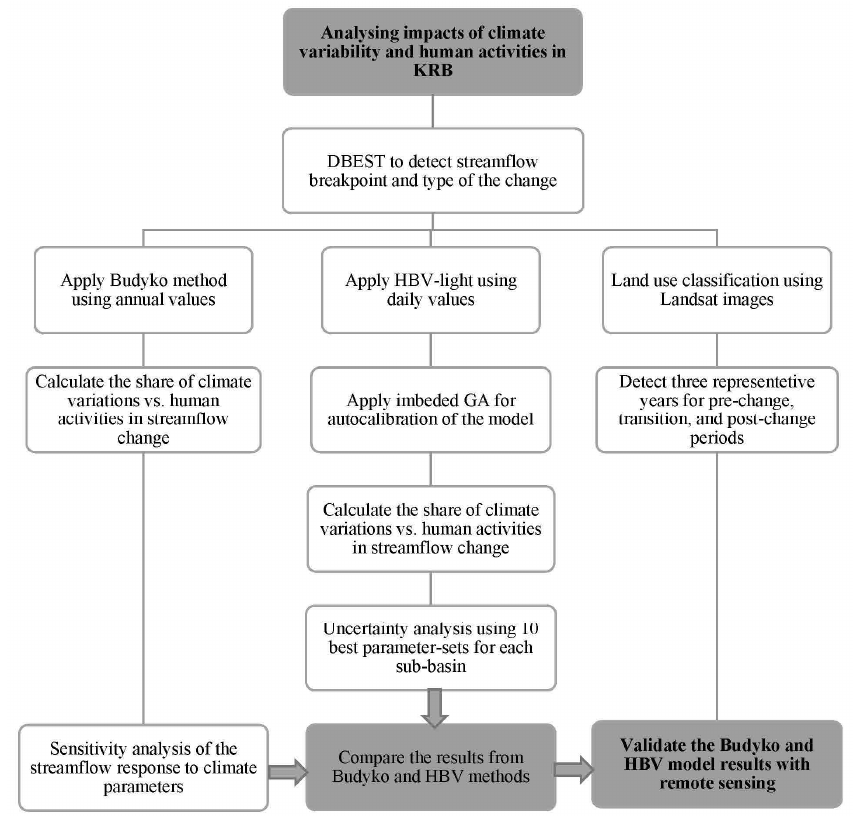
Figure 2. Flowchart of the implemented methodology.